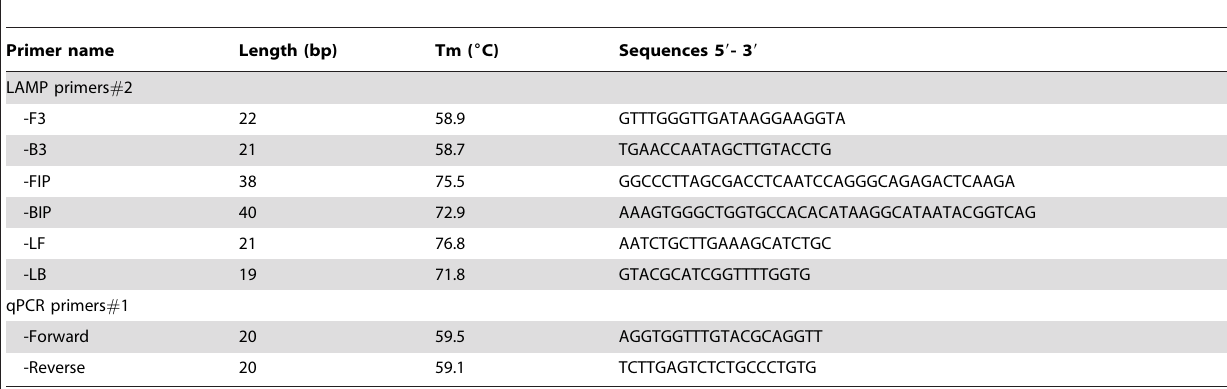
Table 1. Description of LAMP and qPCR primers used for detection of B.